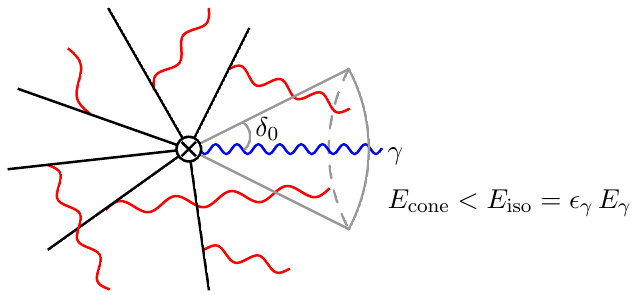
Figure 8 . Pictorial representation of the factorization for isolated photon production. The black lines represent hard partons, while the wavy red lines indicate soft radiation. The energy inside the isolation cone of half-angle (cid:14) 0 is restricted to be smaller than (cid:15) (cid:13) E (cid:13)